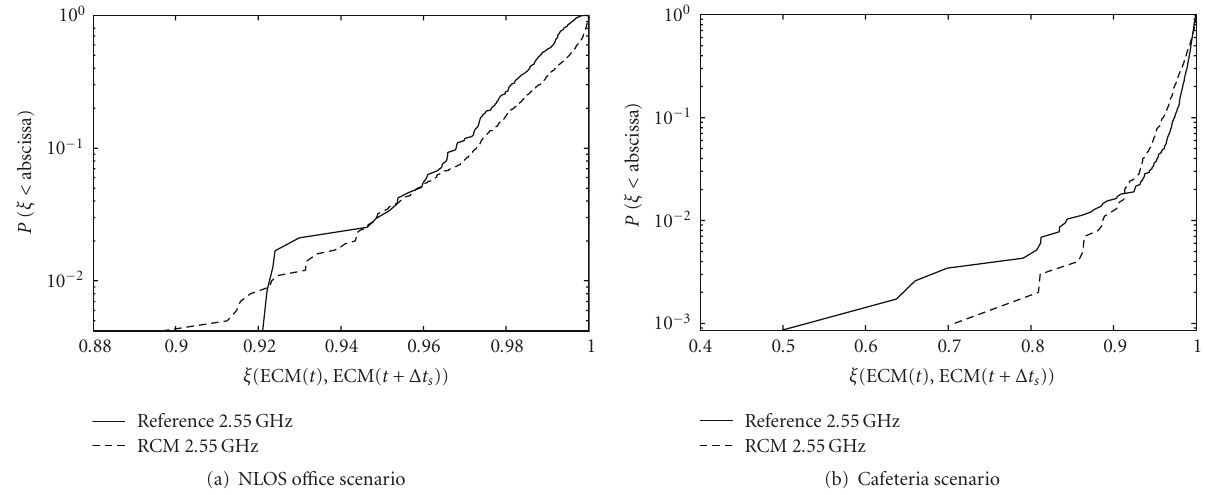
Figure 7: Time-variant validation using the Environment Characterisation Metric: CDF of collinearity between snapshots adjacent in time ( Δ t = 0 . 22